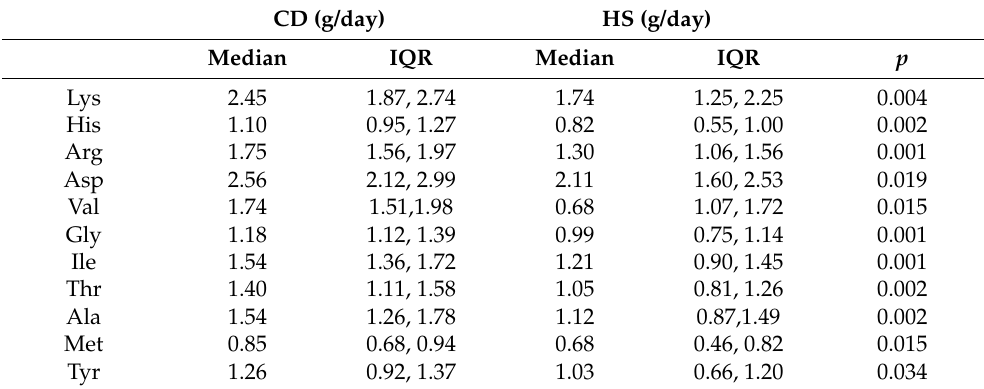
Table 1. Medians ± IQR of 7-day amino acids oral intake in CD patients and healthy subjects. CD (g/day) HS (g/day)